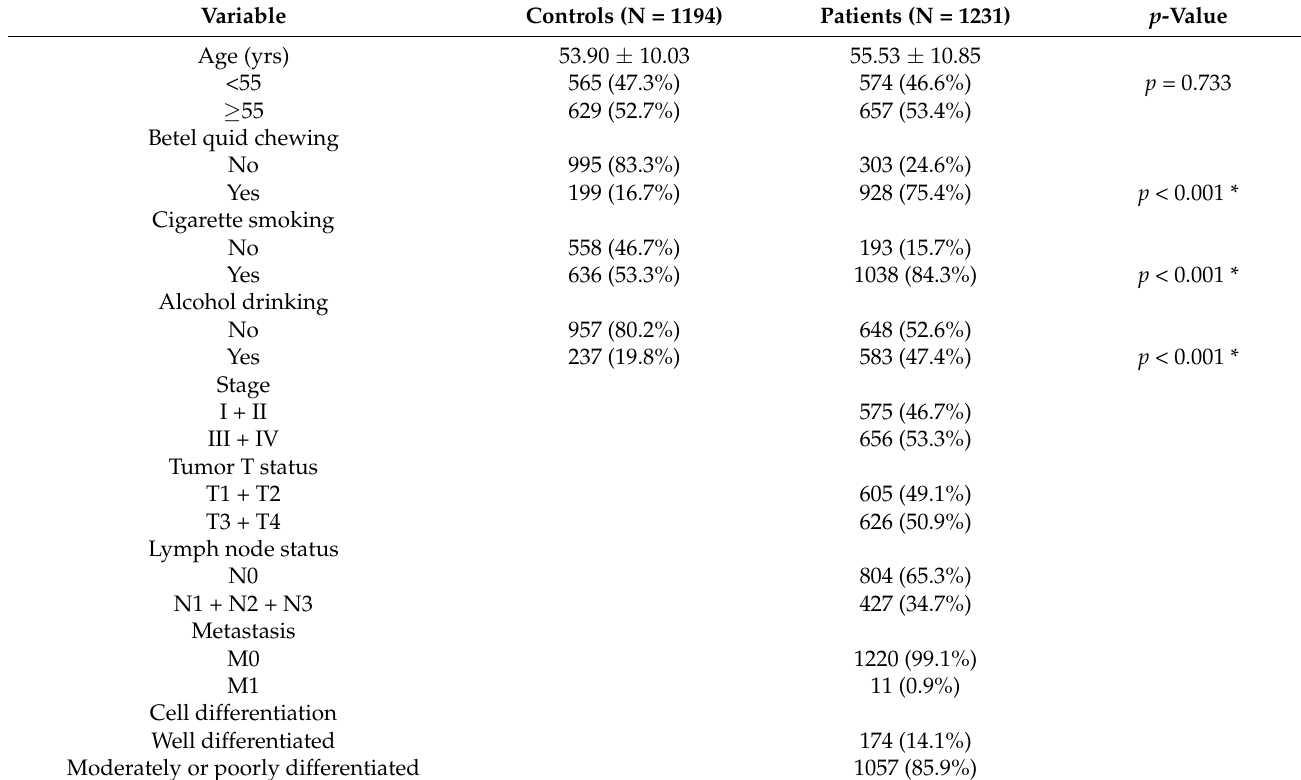
Table 1. The distributions of demographical characteristics and clinical parameters in 1195 controls and 1125 cases with OSCC.